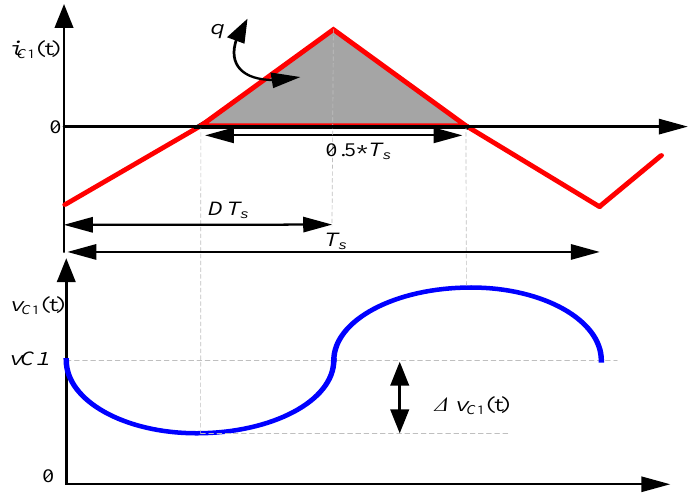
Figure 10. The capacitor C 1 current and voltage.